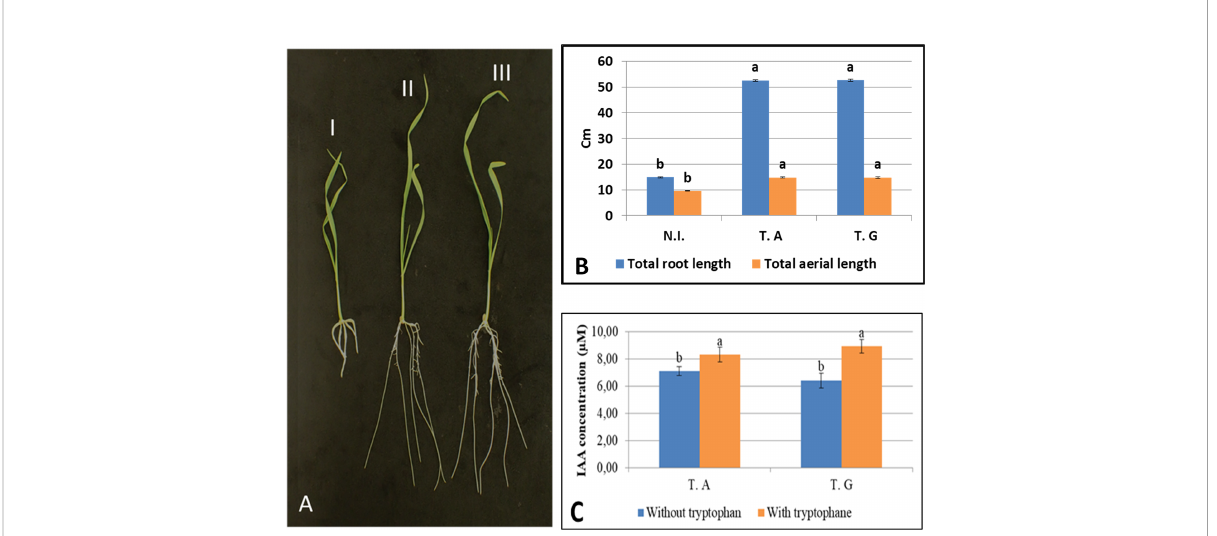
FIGURE 4 Growth of roots and aerial parts after 10 days of culture, with and without Trichoderma (A) ; I) not inoculated, II) a representative seedling inoculated with T. guizhouense , III) a representative seedling inoculated with T. afroharzianum , (B) Total root, and aerial length (cm) of non- inoculated (N.I.) or inoculated wheat plants with T. afroharzianum (T.A) and T. guizhouense (T.G), respectively, (C) IAA production capability of the two Trichoderma isolates (T.G and T.A) with and without tryptophan. Values in the same graph having different letters are signi fi cantly different, at P ≤ 0.01 (ANOVA test).